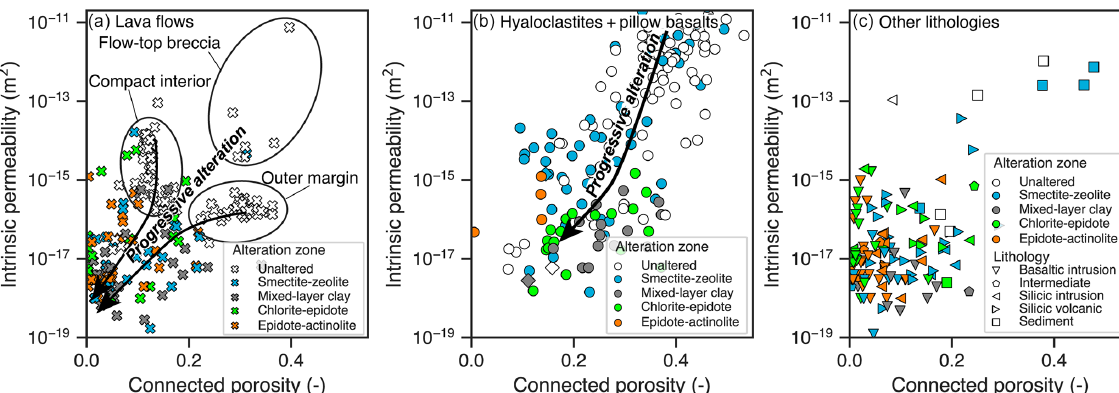
Figure 11. The relationship between connected porosity and intrinsic permeability in (a) lava flows, (b) hyaloclastites and pillow basalts, and (c) other lithologies, including basaltic intrusions, silicic intrusions, silicic volcanics, intermediate rocks, and sediments. Samples are colored by alteration zone, with symbols corresponding to different